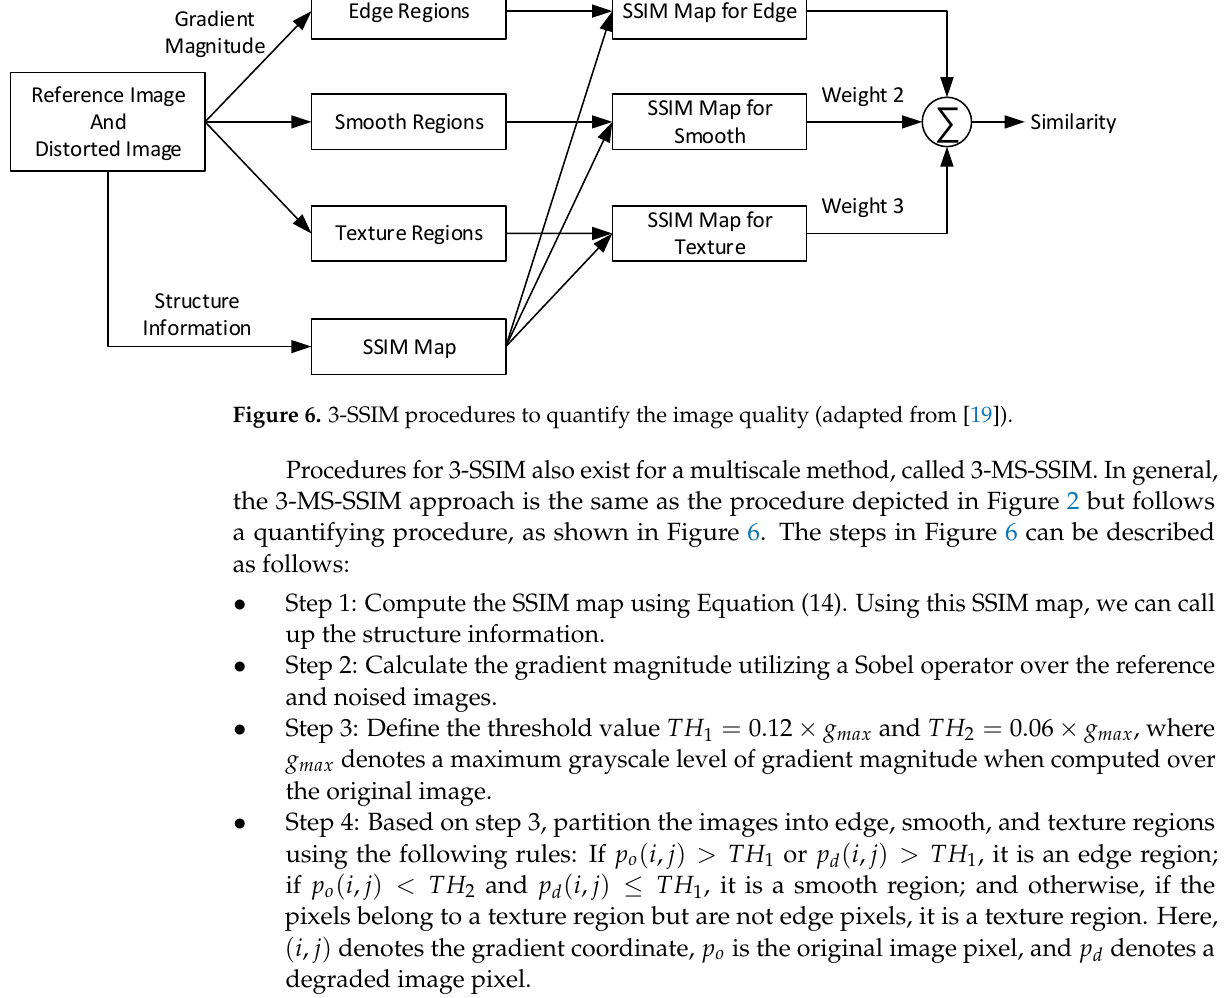
Figure 7. Demonstration using “Lena” to present ( a ) original image, ( b ) blurred image, ( c ) edge pixel image, ( d ) smooth pixel image, and ( e ) texture pixel image. Figure 6. 3-SSIM procedures to quantify the image quality (adapted from [19]).